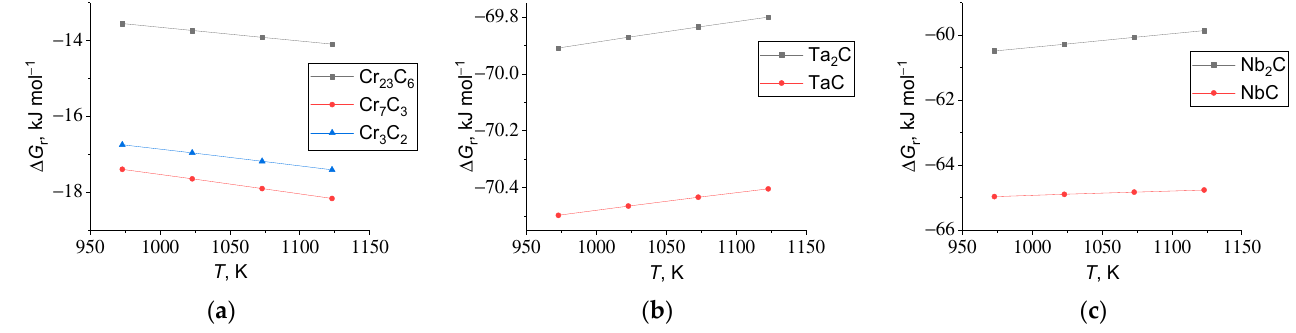
Figure 5. Temperature dependencies of the Gibbs energy for the formation reactions of ( a )—chromium, ( b )—tantalum, and ( c )—niobium carbides from the elements.